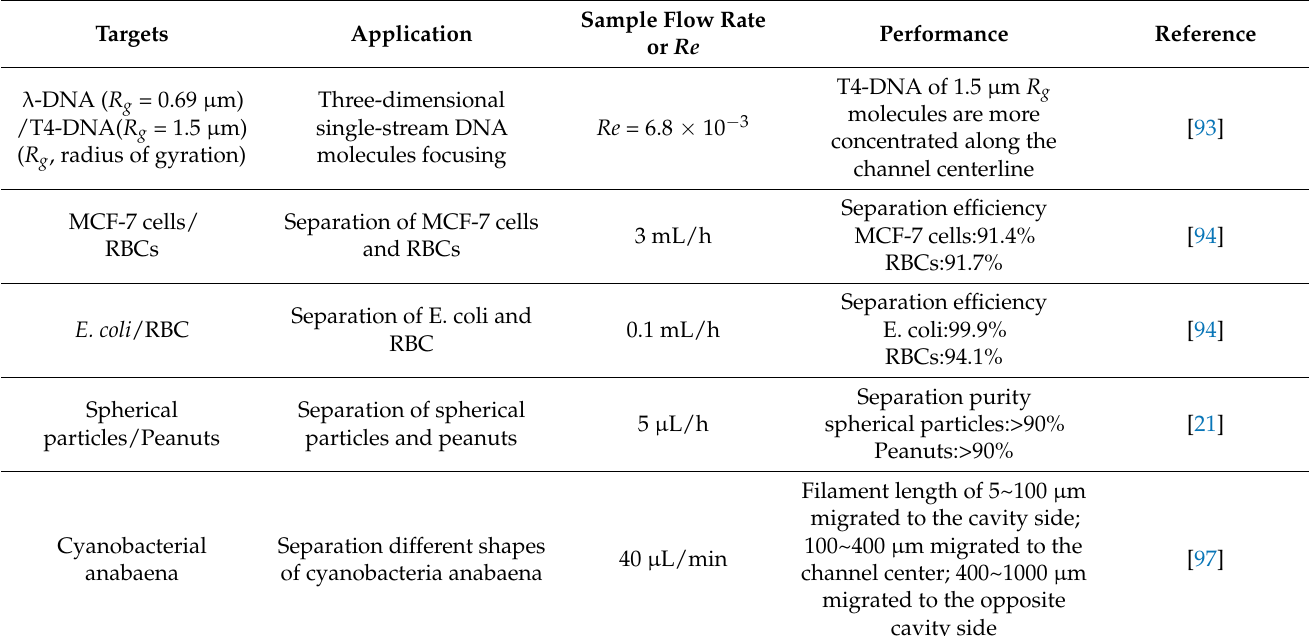
Table 3. Recent advances in non-spherical particles in elastic-inertial microfluidics.